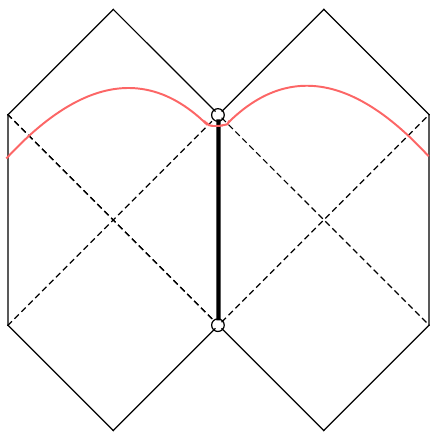
Figure 3 . Time-independent charged wormhole which is constructed by sewing two AdS-RN spacetimes together along a domain wall (thick line). Due to the internal in(cid:12)nities (small circles), the Cauchy horizons are union of the Cauchy horizons of the two AdS-RN spacetimes. Limits of Cauchy surfaces like the one shown (red) can reach such